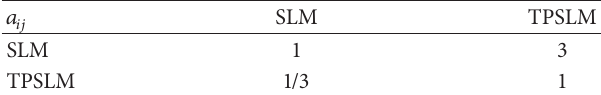
Table 10: Judgment matrix of model